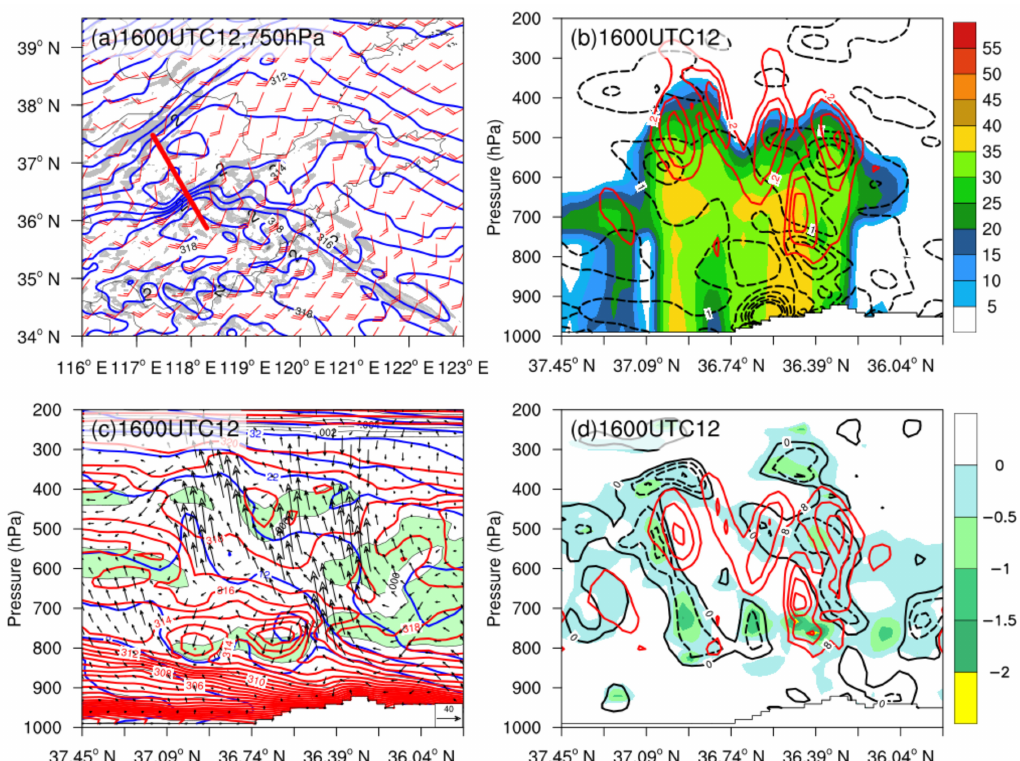
Figure 13. As in Figure 10, but for the 4 km run valid at 1600 UTC 12 February 2016.